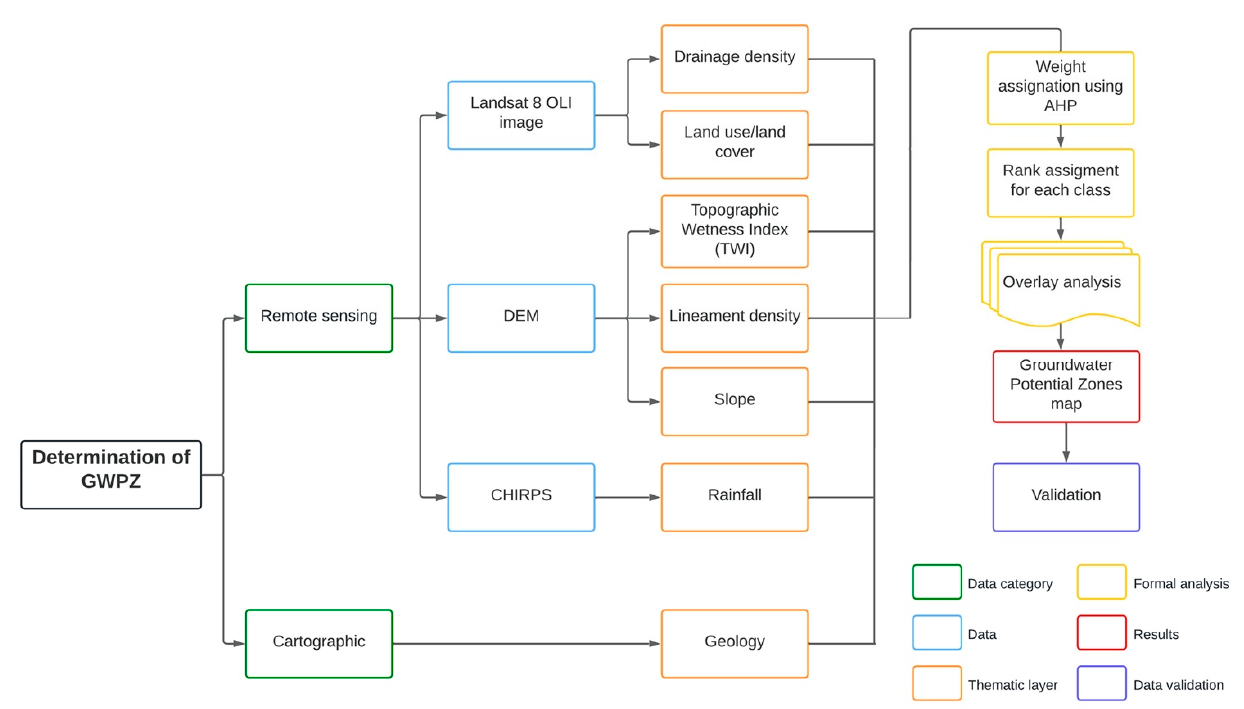
Figure 3. Methodology of this work.